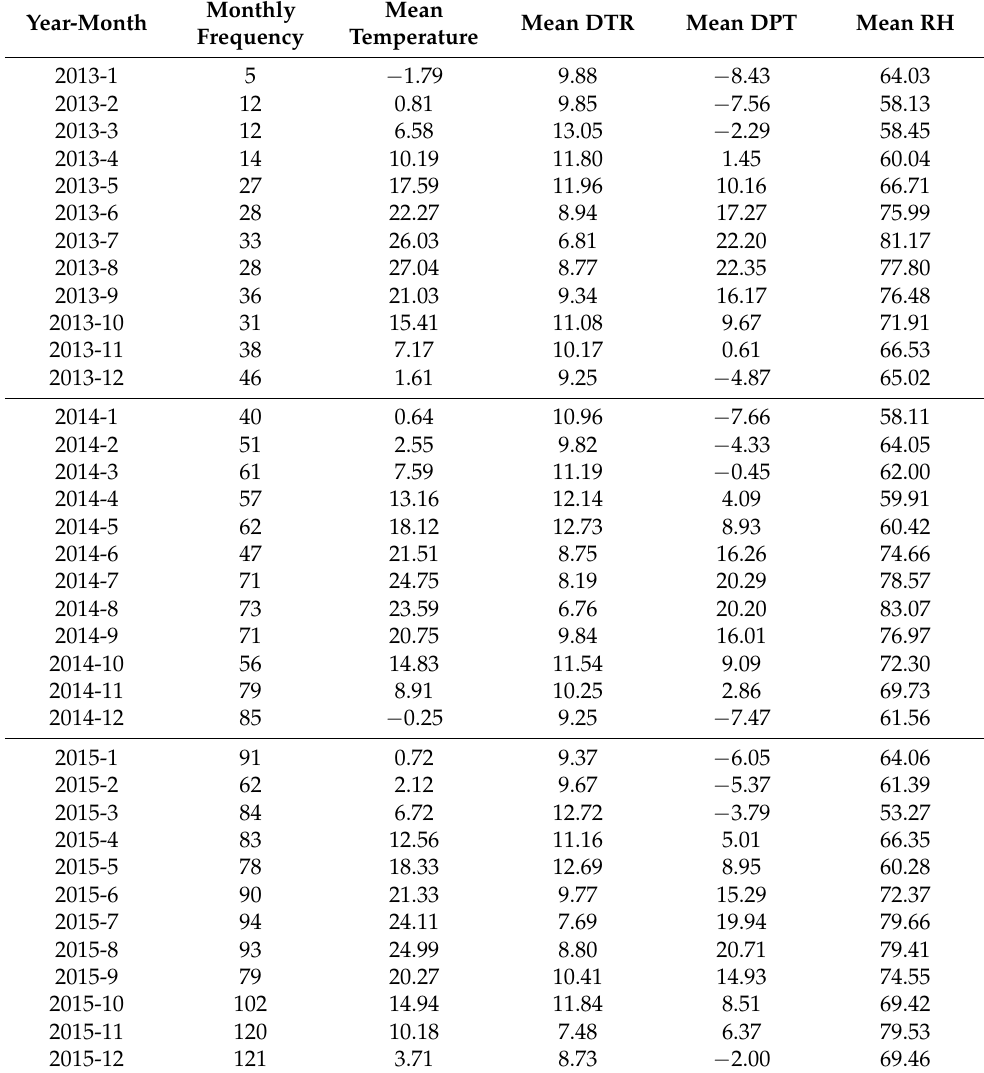
Table 1. Monthly diabetic foot amputation frequency and mean temperature and